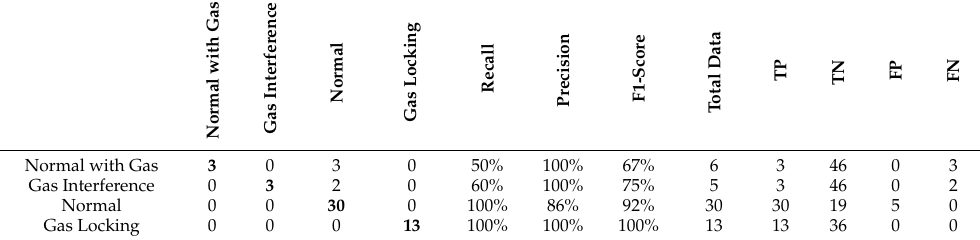
Table 6. SVM parameters with hyperparameters and with unbalanced data. N o r m a l w it h G a s